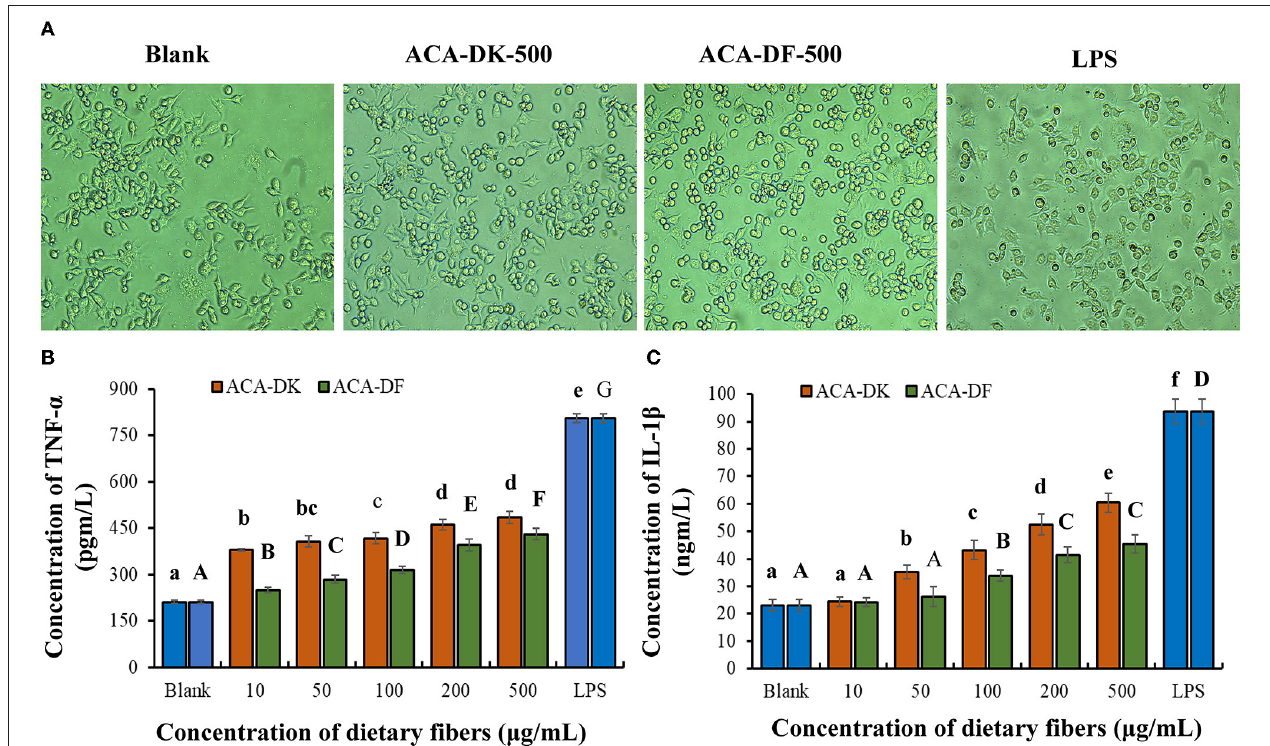
FIGURE 6 | Effect of ACA-DK and ACA-DF on the (A) cell morphology, (B) TNF- α , and (C) IL-1 β production of RAW 264.7 cells. The cells were treated with increasing concentrations of ACA-DK and ACA-DF (10, 50, 100, 200, 500 µ g/mL) for 24h, respectively; LPS (1 µ g/mL) as a positive control. Results of experiments are express as mean ± SEM for each experimental group ( n = 6). The significance of differences between the data was assessed using one-way ANOVA by Dunnett’s tests, with the level of significance set at P <